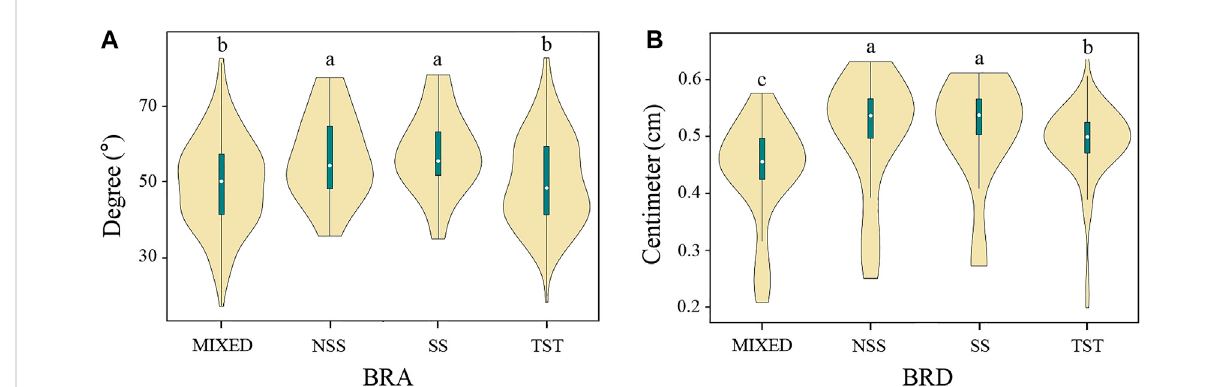
FIGURE 3 Violin plotofBRAand BRDofthefour major subgroups. (A) BRA, (B) BRD. SS ,thestiffstalk subgroup; NSS ,thenon-stiff stalksubgroup; TST ,the tropical-subtropical subgroup; MIXED , admixed subgroups. ANOVA was used to examine phenotypic differences between different subgroups. a, b and c indicate statically signi fi cant differences at p ≤